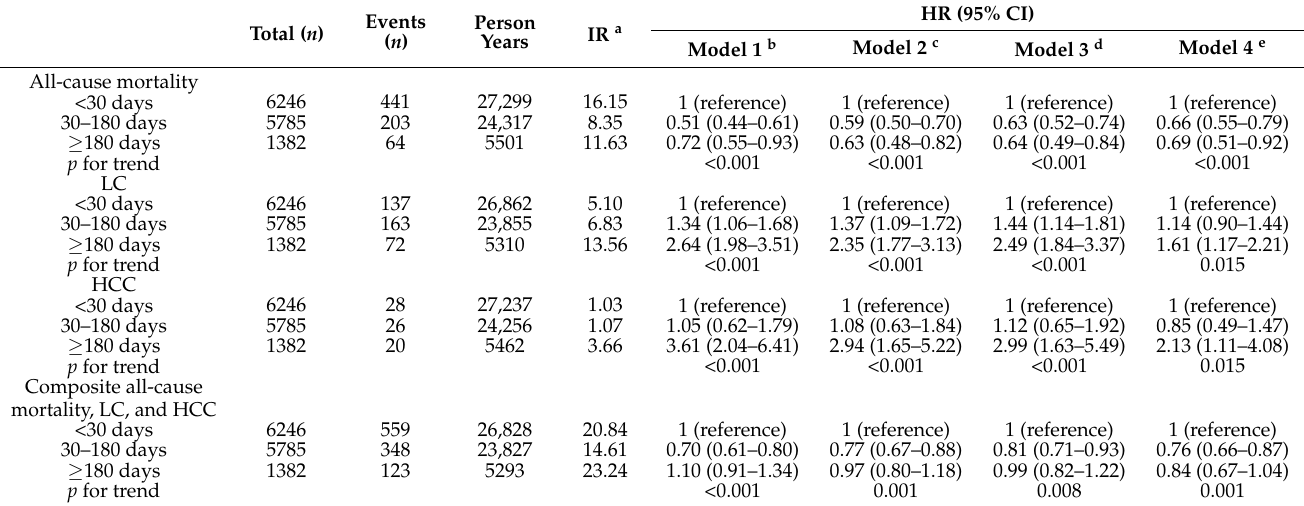
Table 2. HRs (95% CIs) of the risks of all-cause mortality, LC, HCC, and the composite outcome according to the duration of use of carnitine-orotate